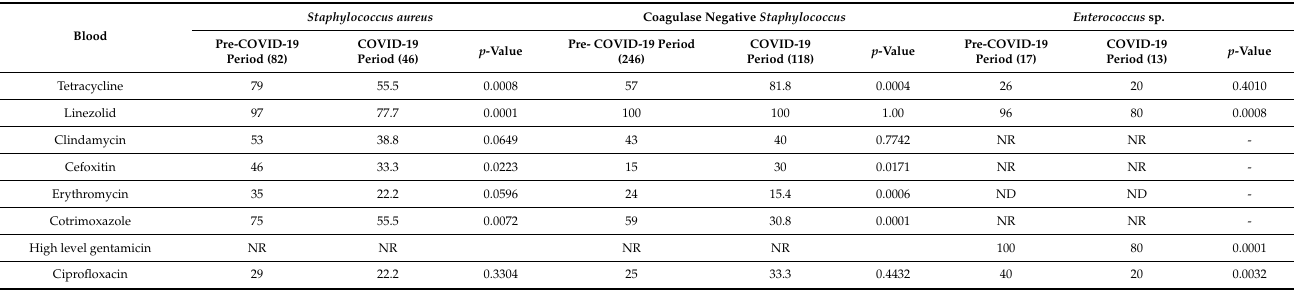
Table 4. Comparison of antimicrobial susceptibility pattern of Gram positive bacteria in blood samples between pre-COVID- 19 and COVID-19